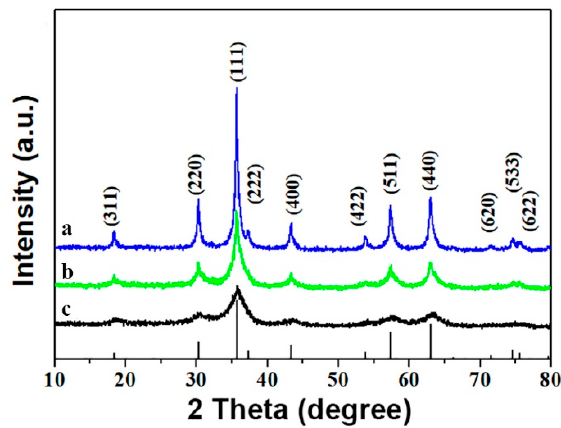
Figure 2. The XRD patterns of the prepared ZnGa 2 O 4 samples: ( a ) n-ZGO, ( b ) P-ZGO and ( c ) ZGO@C. Table 1. The crystallite size, band gap, BET surface area (S BET ), maximum values of the toluene conversion and CO 2 production, mineralization e ffi ciencies (E M ), and surface hydroxyl density of various